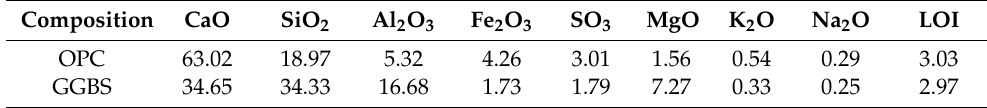
Table 1. Chemical composition of OPC and GGBS (%).